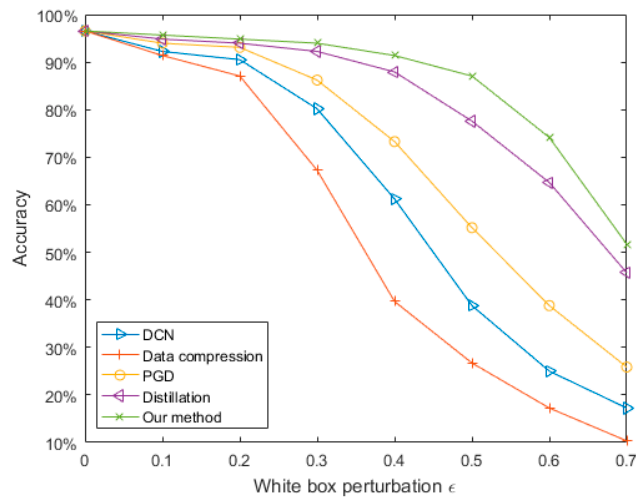
Figure 7. The accuracy of model under different levels of perturbation.